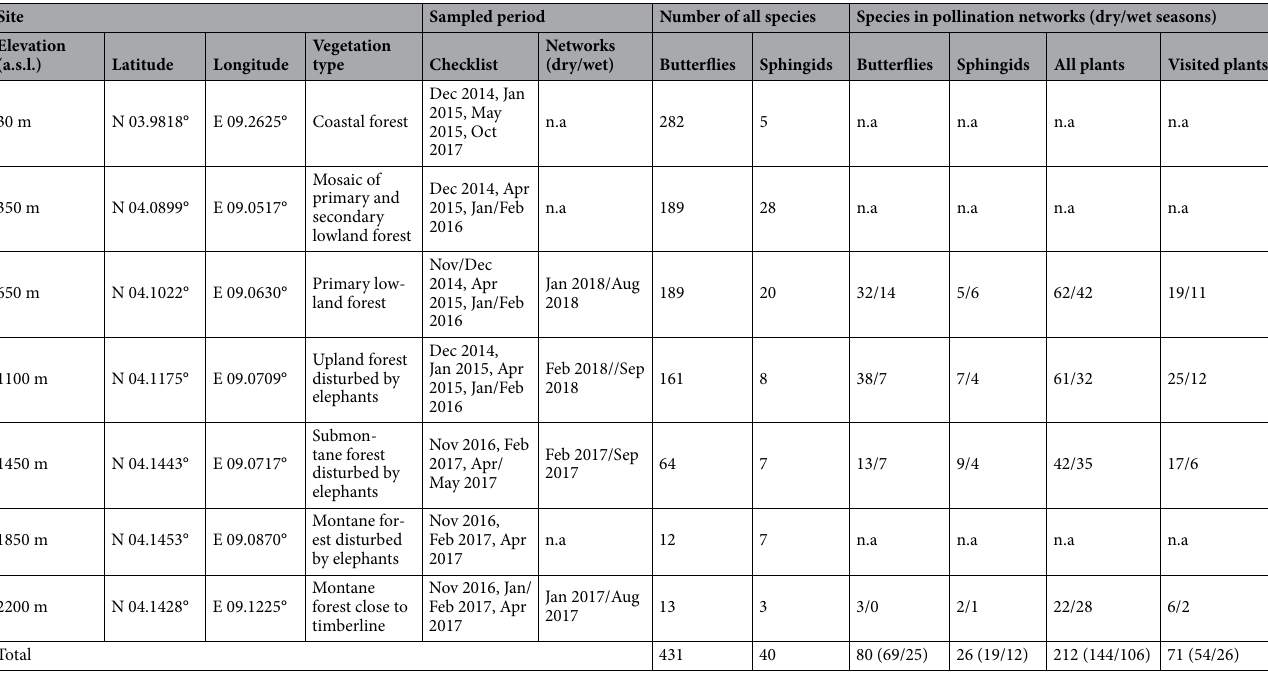
Table 1. Sites on Mount Cameroon sampled for butterflies and sphingids. ‘n.a.’ stands for data not available for particular